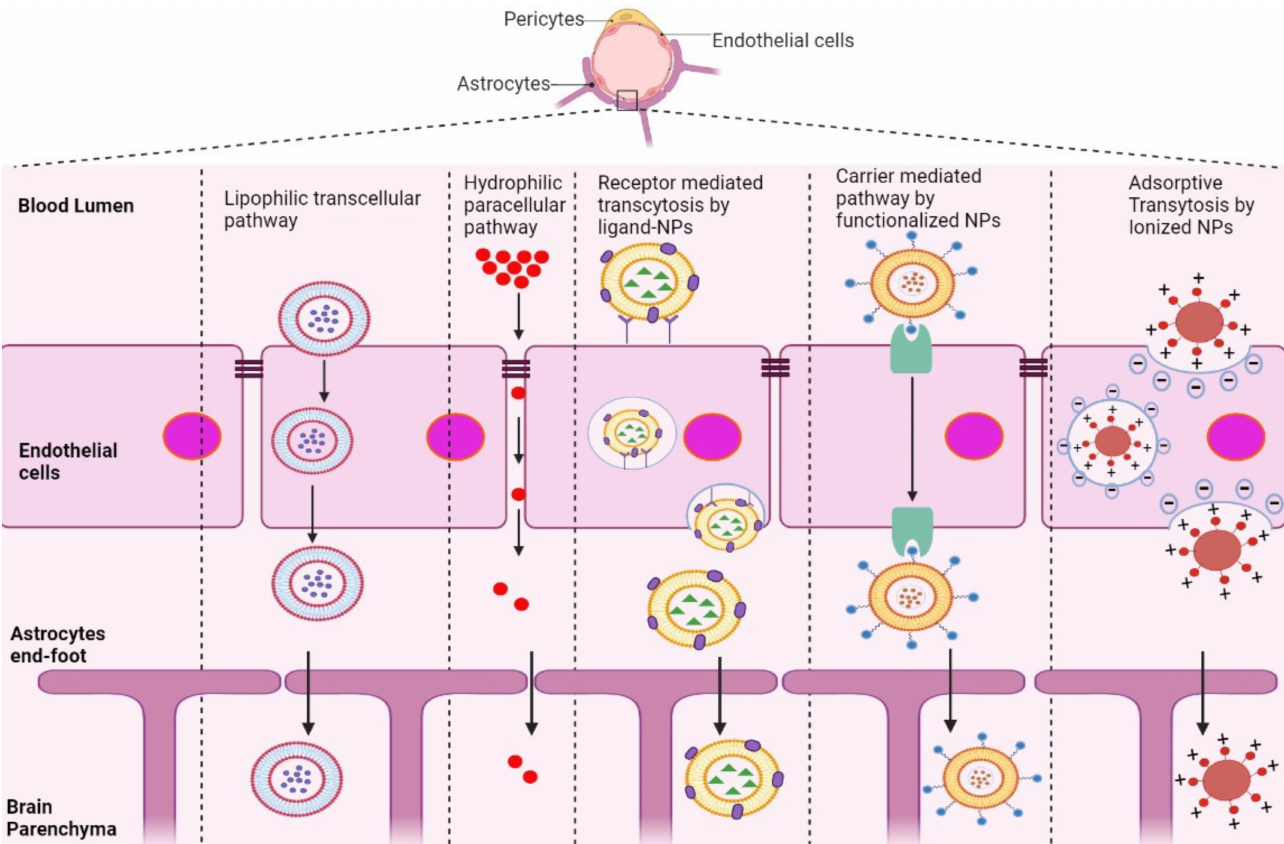
Figure 1. Schematic representation of potential pathways of NP-based drug delivery systems that penetrate the BBB for the treatment of